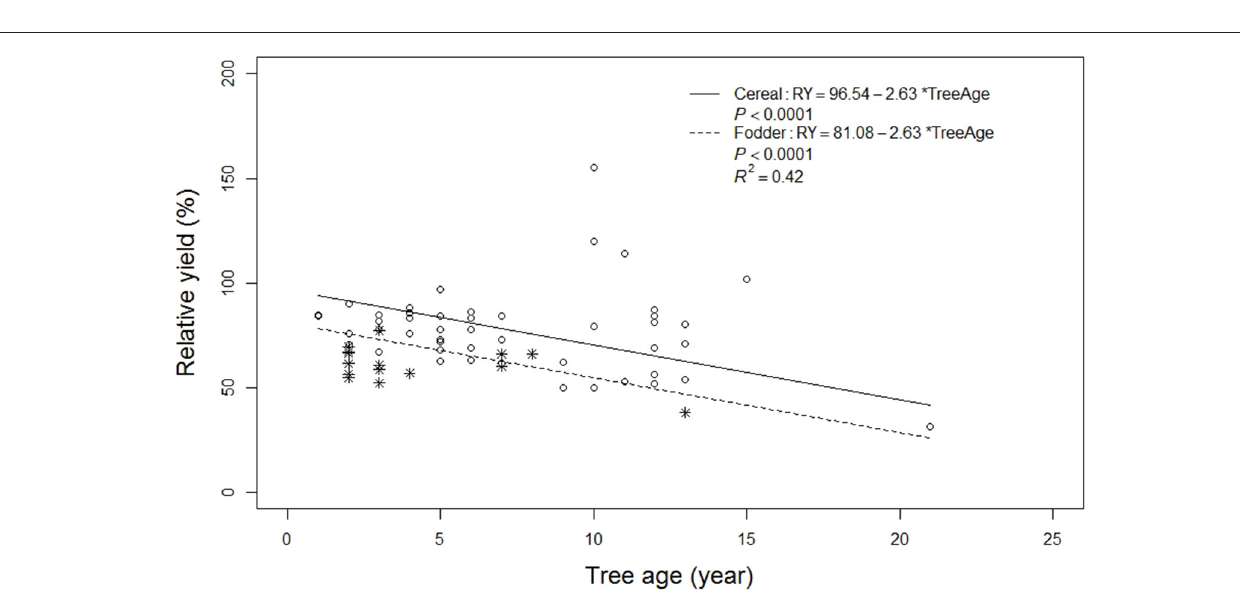
m distance to the nearest tree. However, sensitivity analysis ( Supplementary Material ) indicated that study by Moreno et